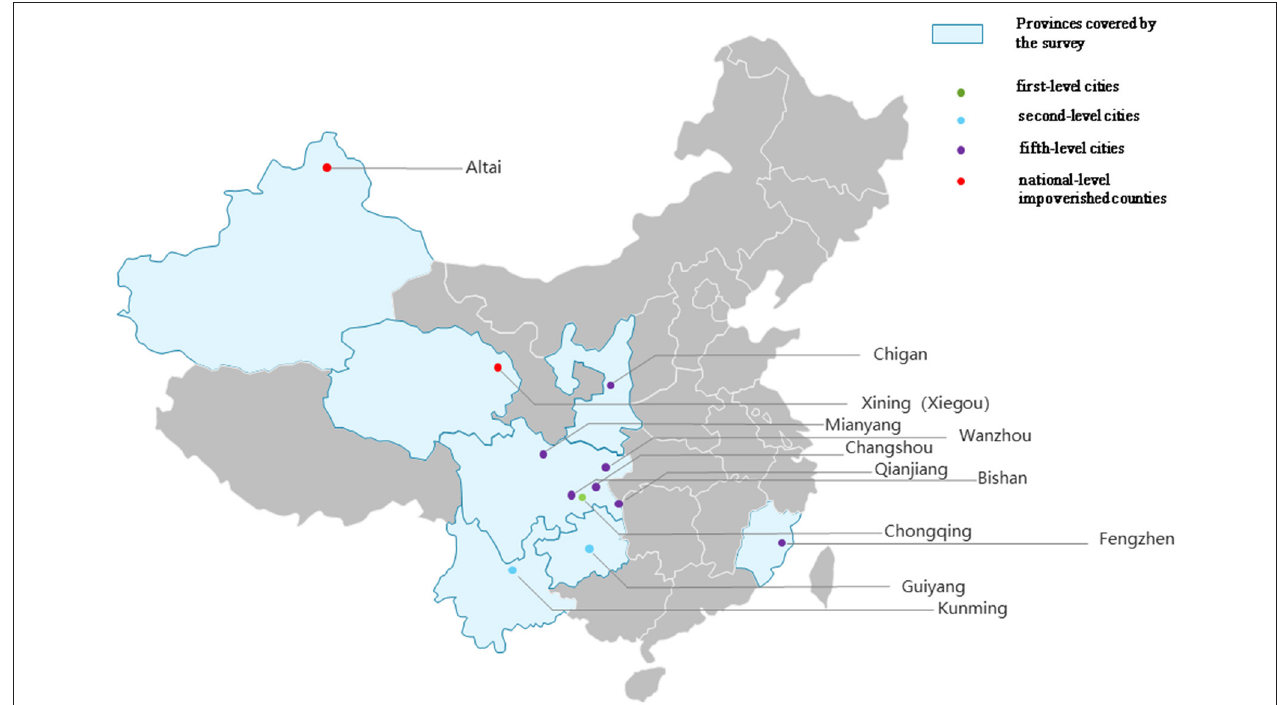
FIGURE 1 | Regions covered by this